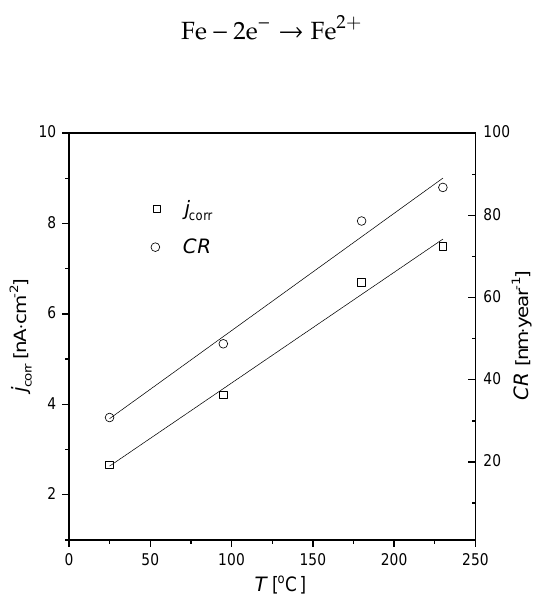
Figure 3. Corrosion current density ( j corr ) and corrosion rate ( CR ) for the AISI 1010 steel electrodes immersed in sulfolane at 25, 95, 180, and 230 ◦ C.